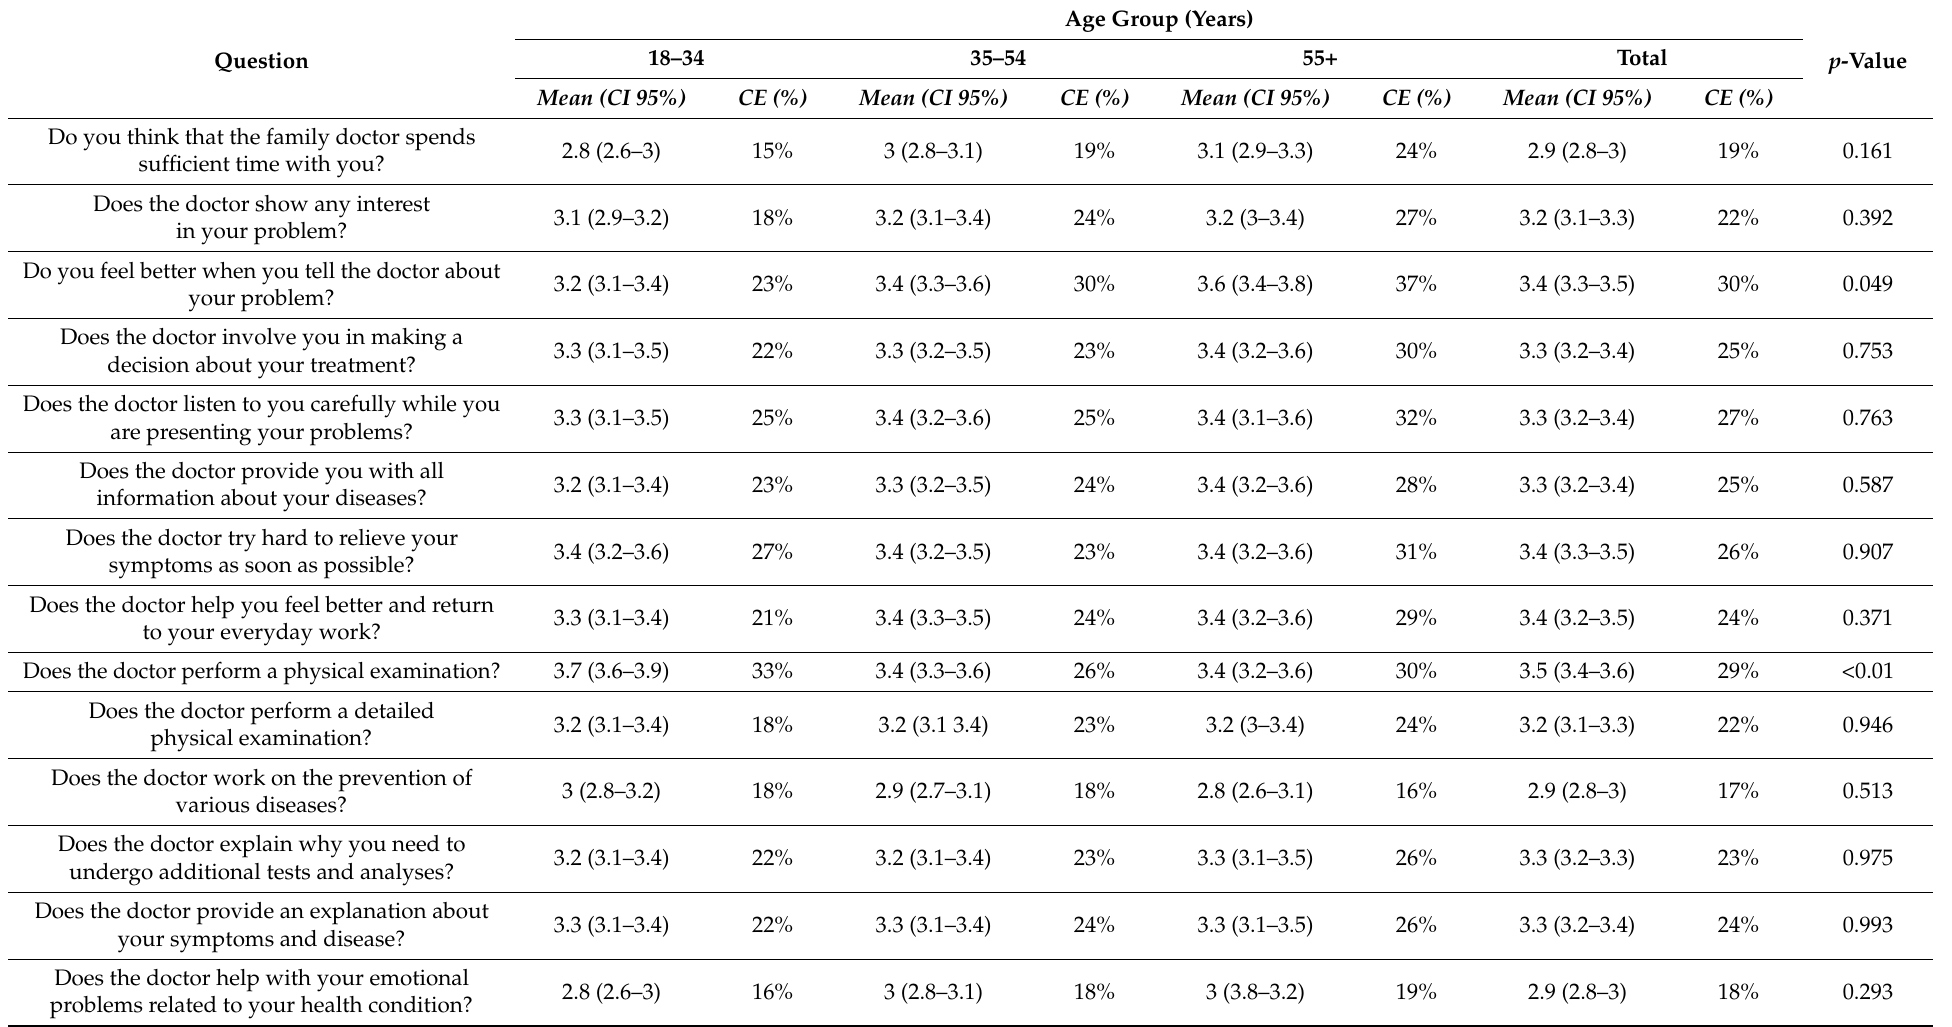
Table 1. Satisfaction with health care in the adult population of the Federation of Bosnia and Herzegovina during the COVID-19 pandemic by age group